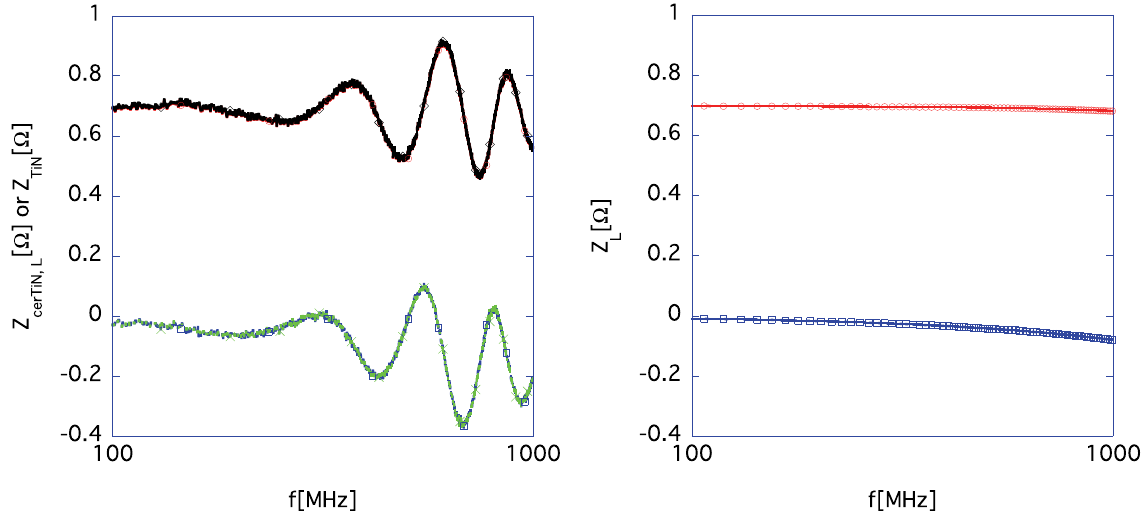
FIG. 7. Measurements (left) and theoretical (right) results of the longitudinal impedance. The longitudinal impedance Z blue) and the electric impedance Z (black/green) are shown overlapped in the left picture. The horizontal axis is frequency in TiN logarithmic scale.